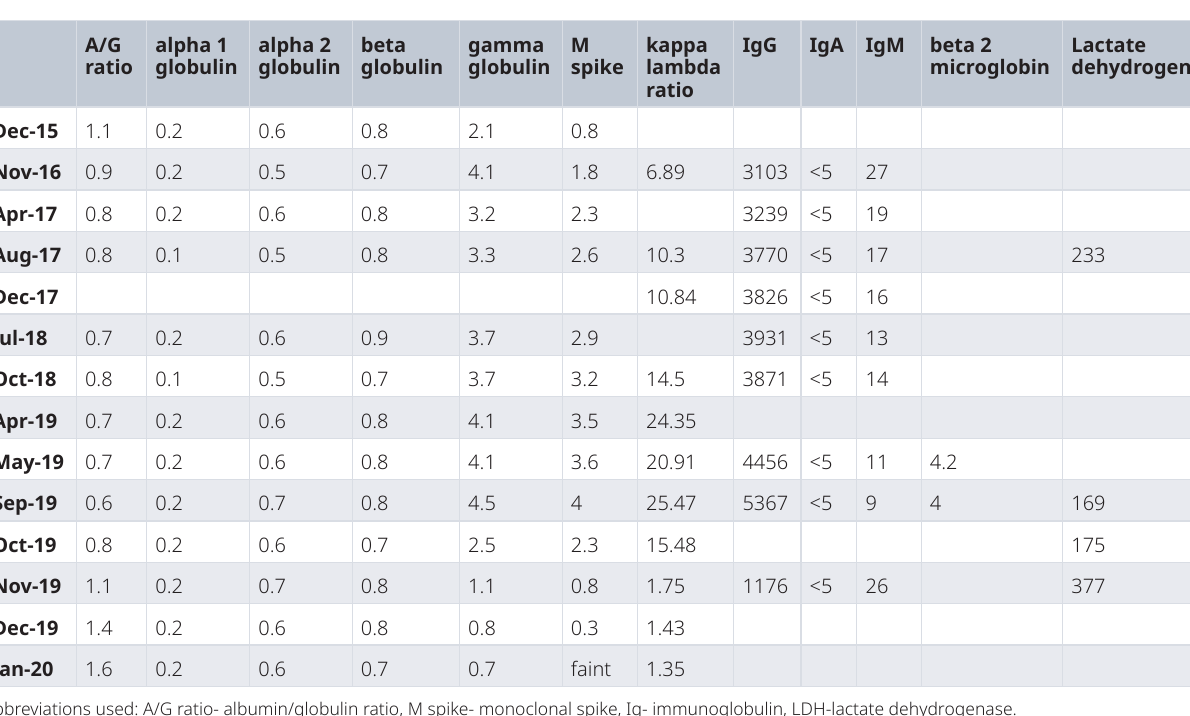
Table 1. Serum electrophoresis results.